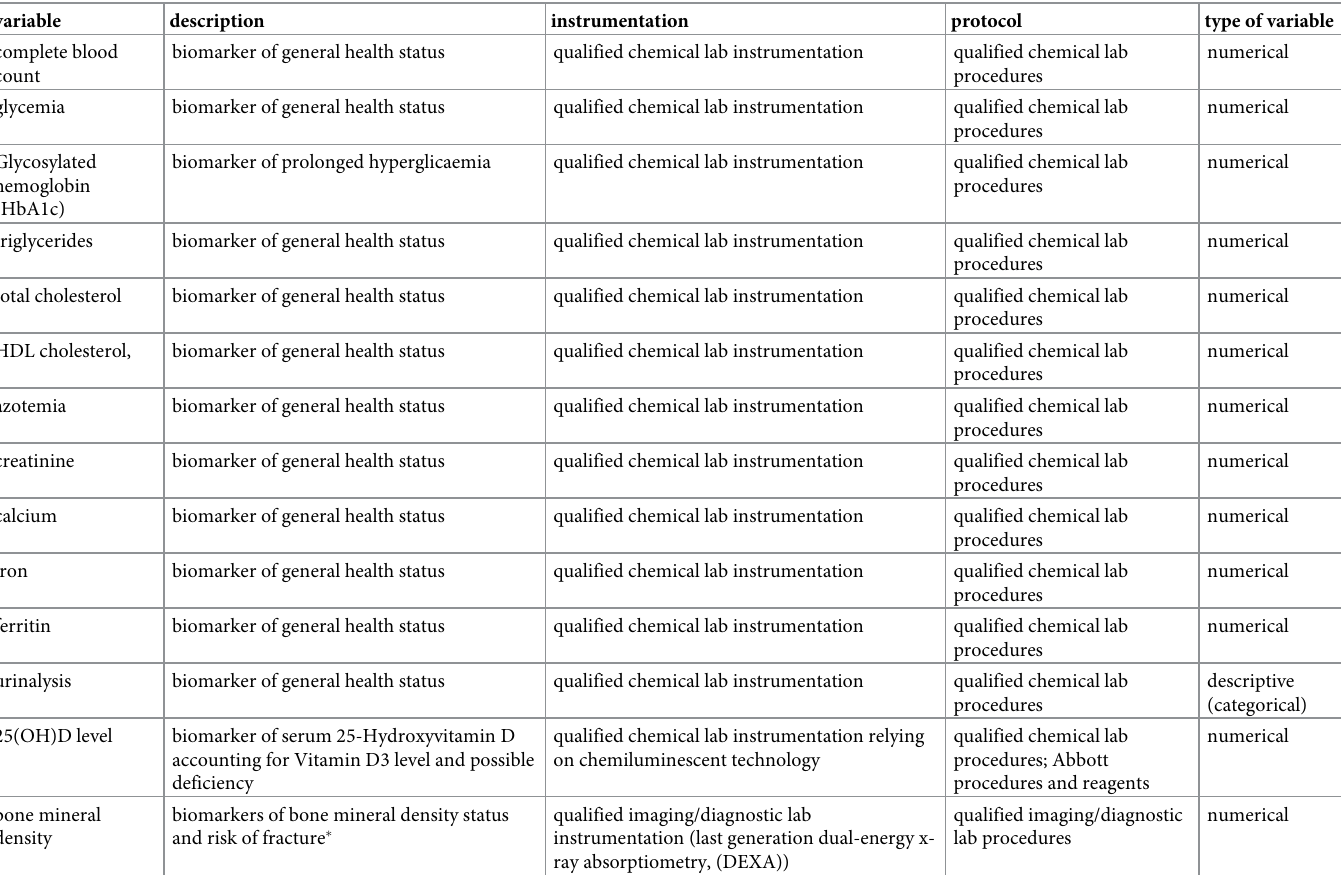
Table 3. Clinical and diagnostic